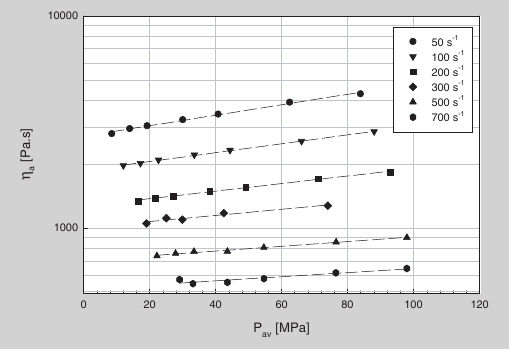
up to back pressures of 120 MPa. The pressure